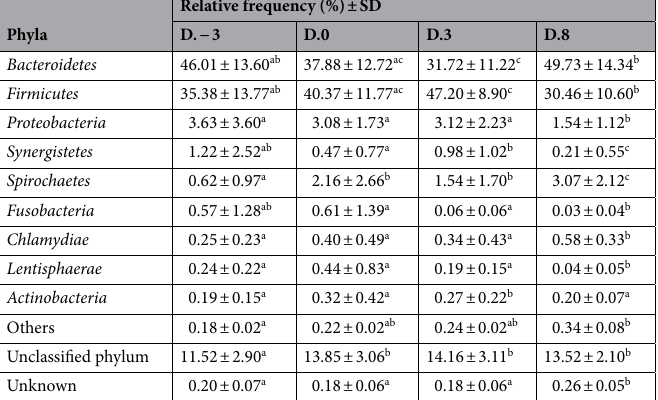
Table 1. The relative abundance of phyla in piglets at day 3 pre-weaning (D. − 3), weaning day (D.0), days 3 (D.3) and 8 post-weaning (D.8). a,b,c A significant difference in the same row at P < 0.05.